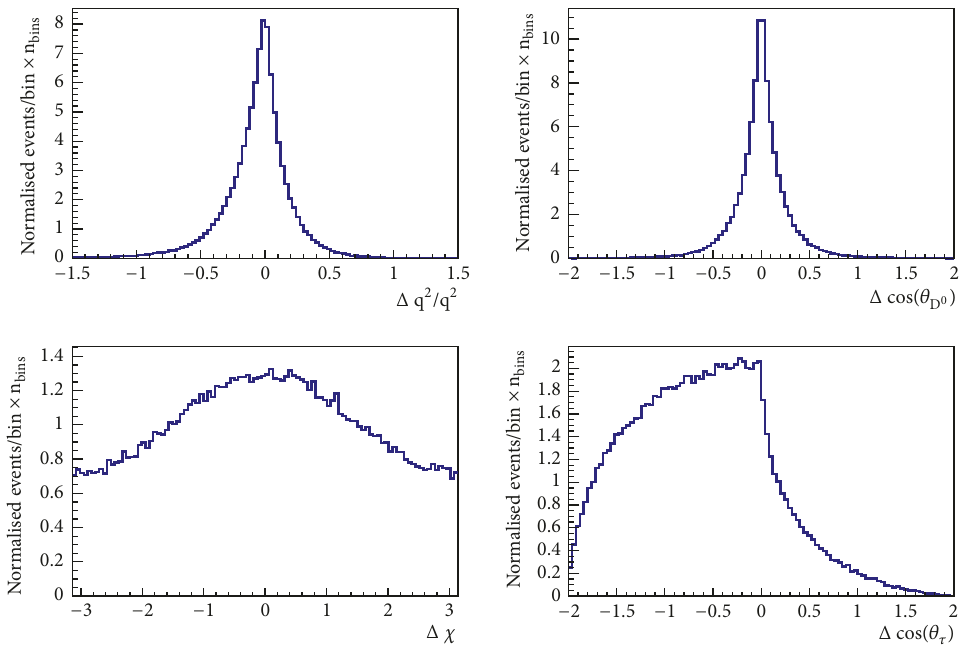
Figure 7: Resolution on the phase space variables for 𝐵 󳨀→ 𝐷 ∗+ 𝜏 − (󳨀→ 𝜋 + 𝜋 − 𝜋 − ] 𝜏 ) ] 𝜏 decays, obtained with equal velocity algorithm.